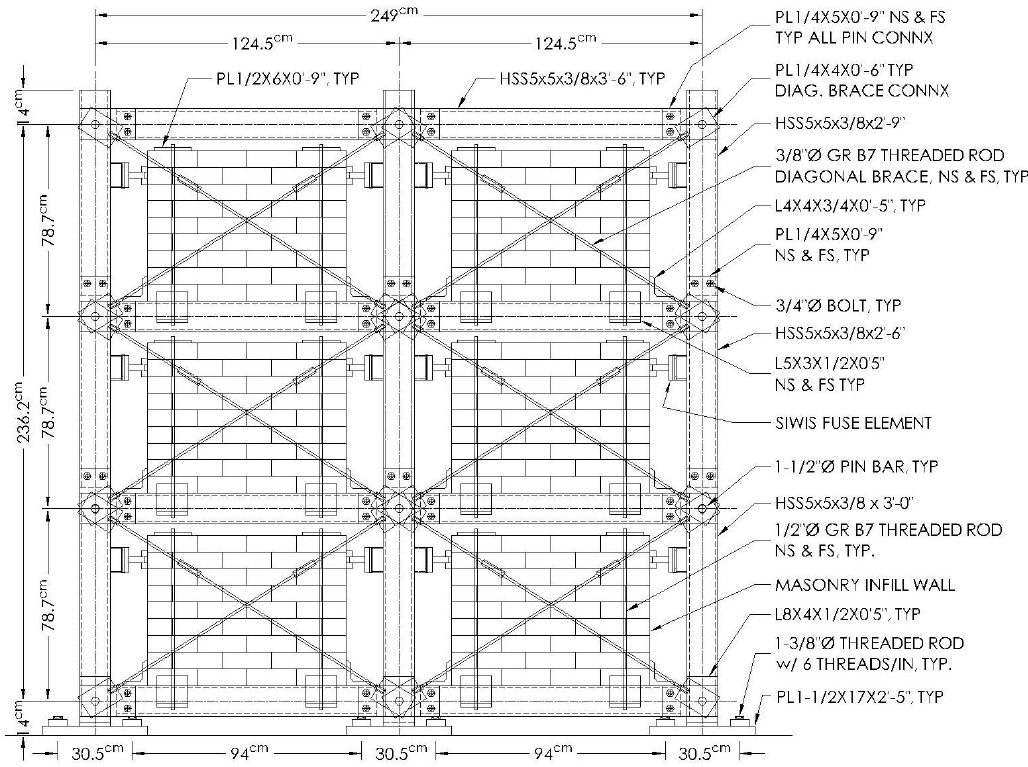
Figure 1. 1/4 scale, two-bay, three-story steel test